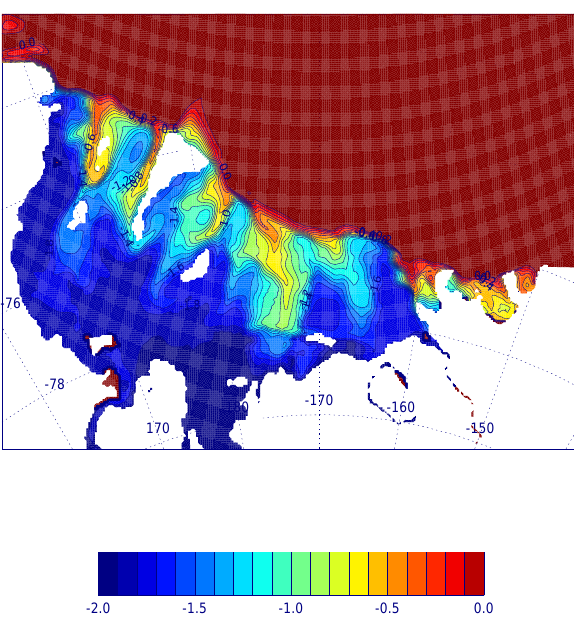
Fig. 3. Annual average salinity at 300m from the simulation model. White areas in the figure are either land or areas that are shallower than 300m.